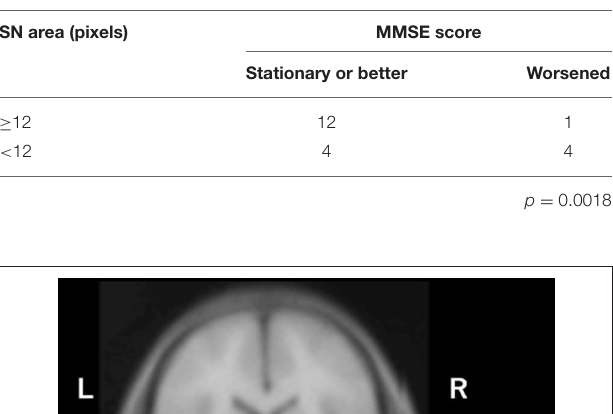
TABLE 4 | Relationship between cognitive function and the SN area in NMI.